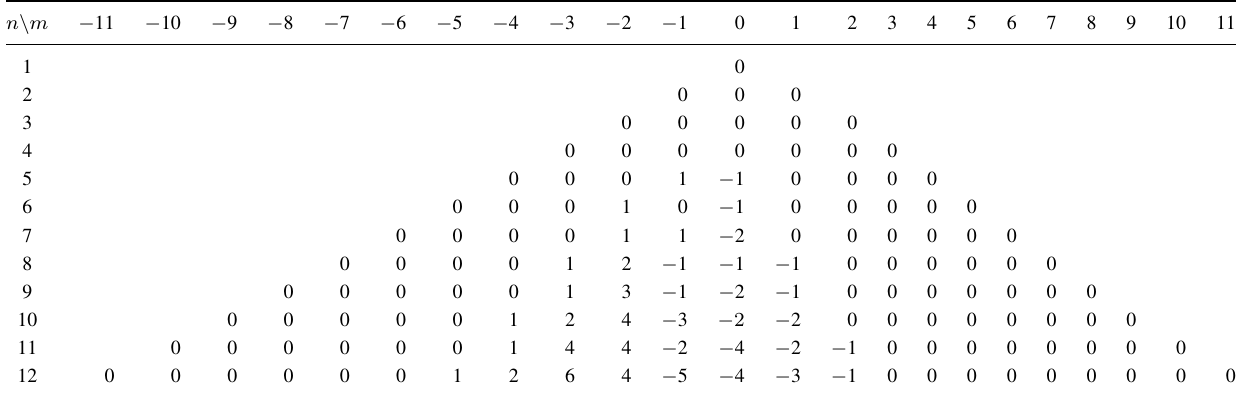
Table 3. A table of values of D ( m, n )